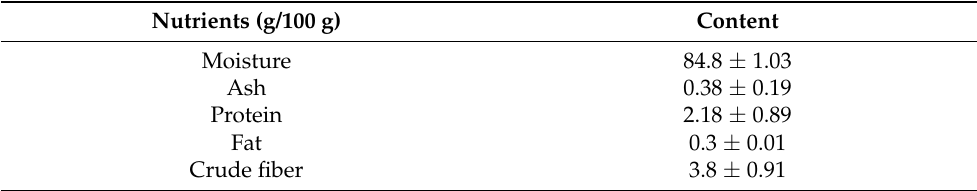
Table 1. The content of nutrients in bean